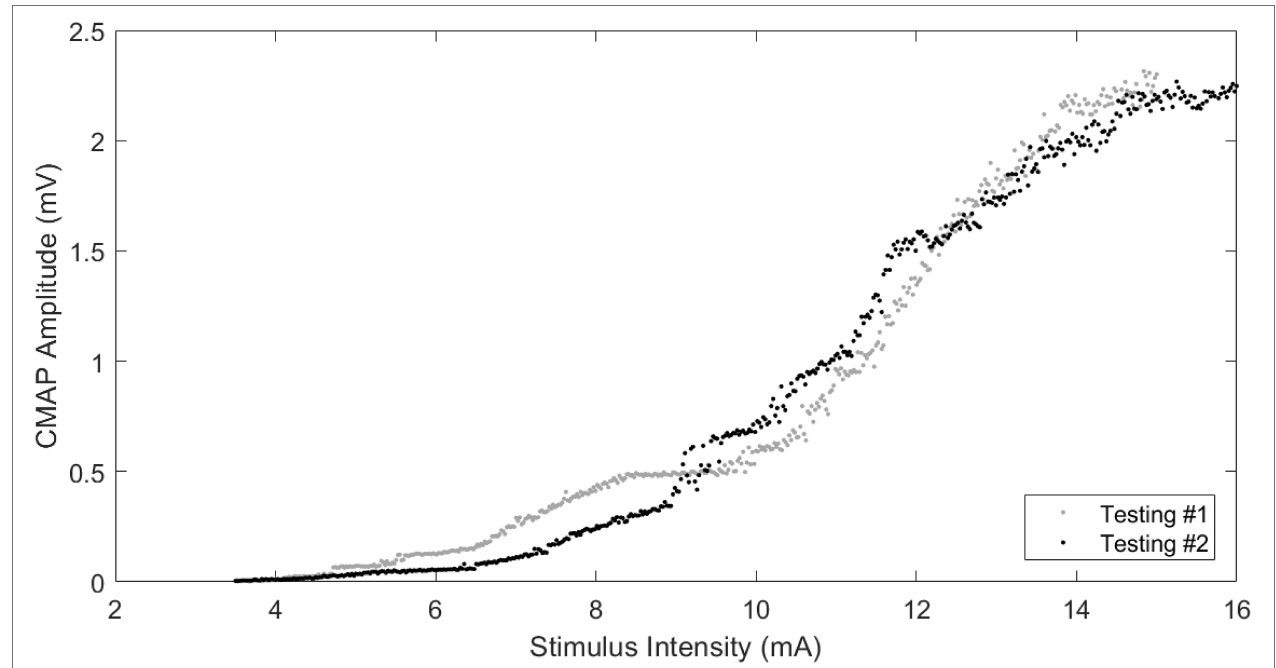
FIGURE 2 | Examples of CMAP scans from the same participant on two different testings. Stimulating range: 3.5–15 mA (testing #1), 3.5–16 mA (testing #2); CMAP amplitude: 2.31 mV (testing #1), 2.27 mV (testing #2); and MUNE: 40 (testing #1), 40 (testing